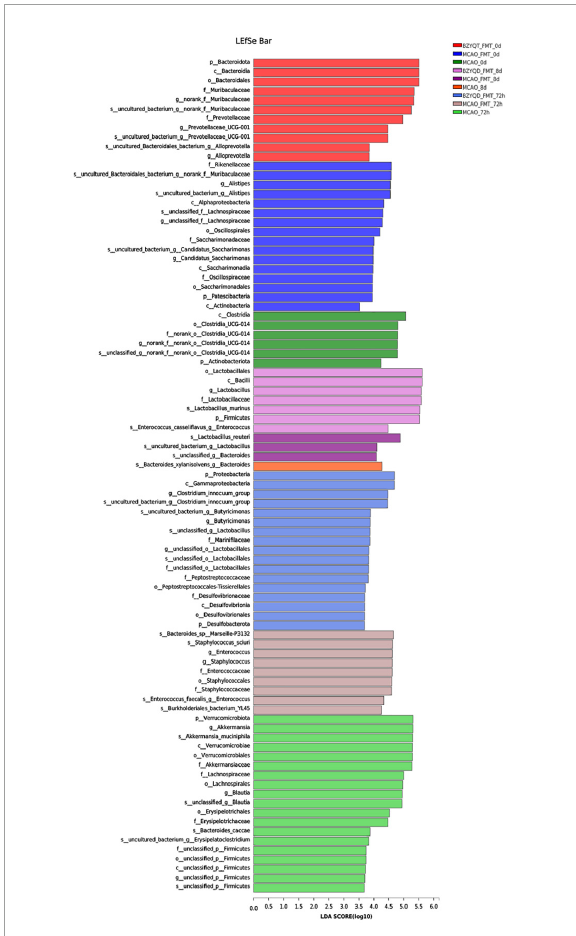
FIGURE6 LEfSe multi-level species difference discriminant analysis for each